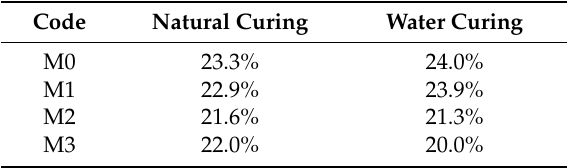
Table 5. The mass loss of MKPC mortar specimen at 200 ◦ Table 4. The mass loss of MKPC mortar specimen at 200°C.